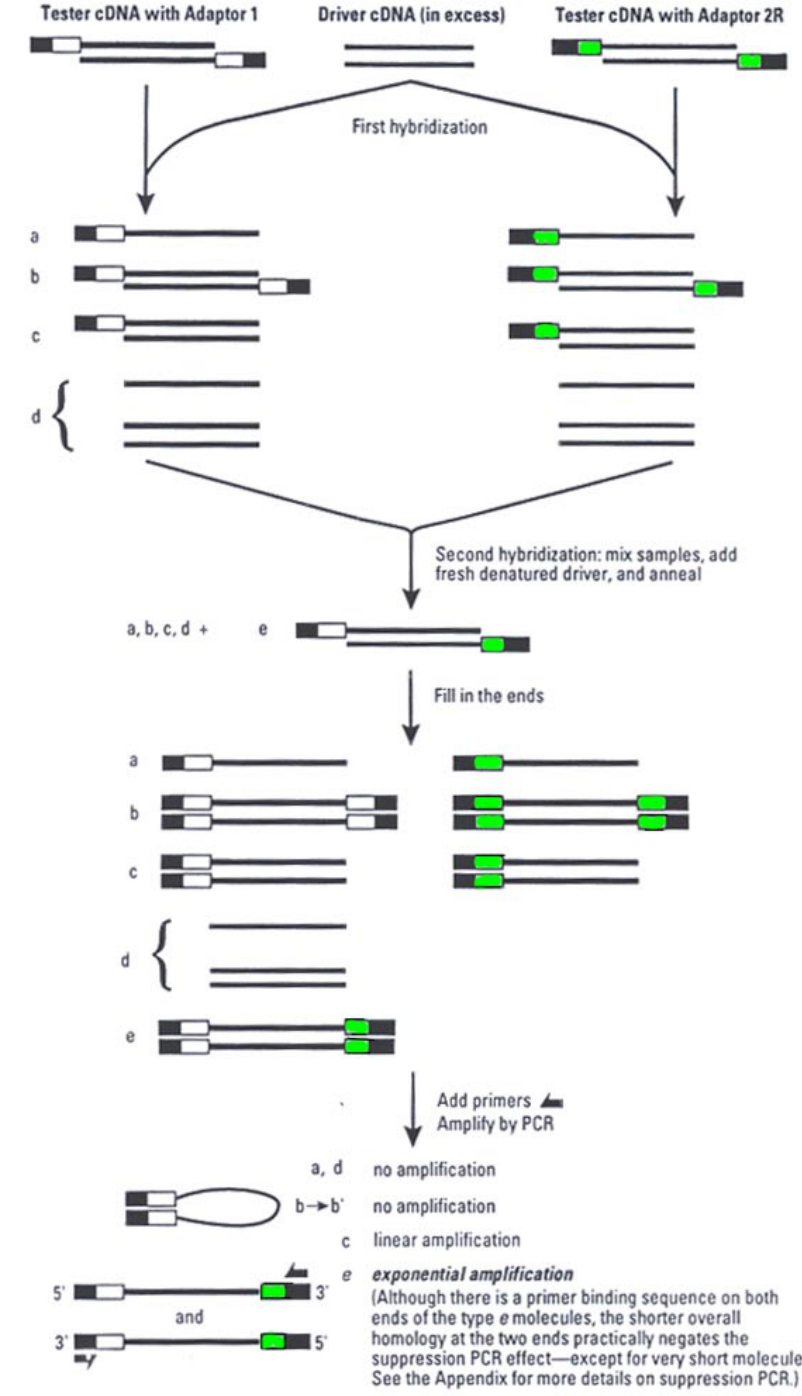
FIGURE 1. Schematic diagram of the SSH. Type e molecules are formed only if the sequence is up-regulated in the tester cDNA. Solid lines represent the Rsa I-digested tester of driver cDNA. Solid boxes represent the outer part of the Adaptor 1 and 2R longer strands and corresponding PCR primer 1 sequence. Green boxes represent the inner part of the Adaptor 1 and the corresponding PCR primer 1 sequence. Green boxes represent the inner part of Adaptor 2R and the corresponding nested PCR primer 2R sequence. (Figure provided by BD Biosciences